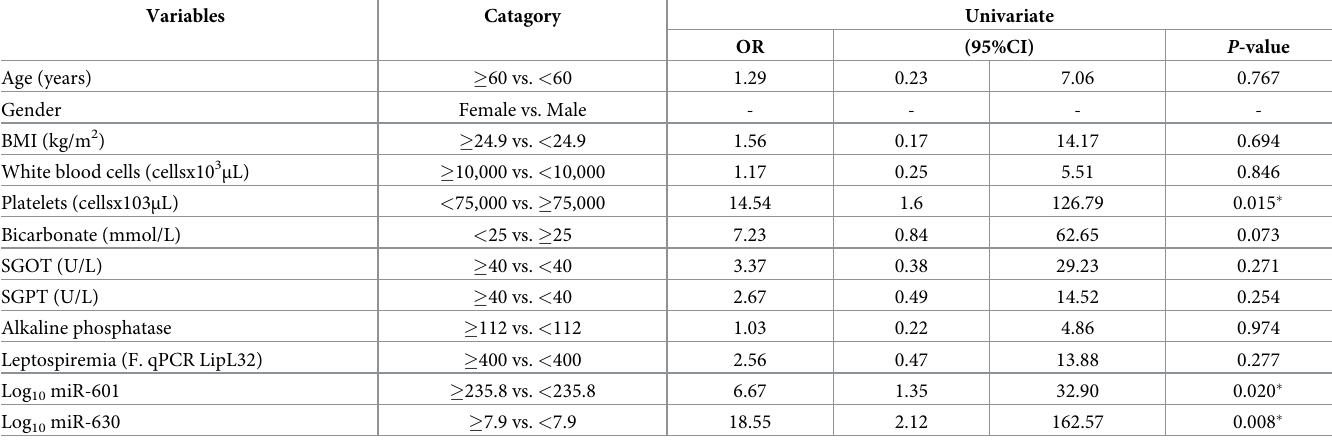
The prediction of target genes to the differentially expressed miRNAs in patients with icteric leptospirosis was performed by TargetScan program. A total of 1,649 and 1,858 target genes were predicted for miR-601 and miR-630, respectively. All targeted genes were then subjected to GO analysis in clusterProfiler R package. The results demonstrated that these genes were categorized as biological process, molecular function and cellular component. Additionally, pathway analysis based on the predicted targets were identified by KEGG pathway analysis. Our result showed that the two miRNAs were enriched in transforming growth factor (TGF)- Table 3. Variables associated with acute liver failure in patients with leptospirosis.